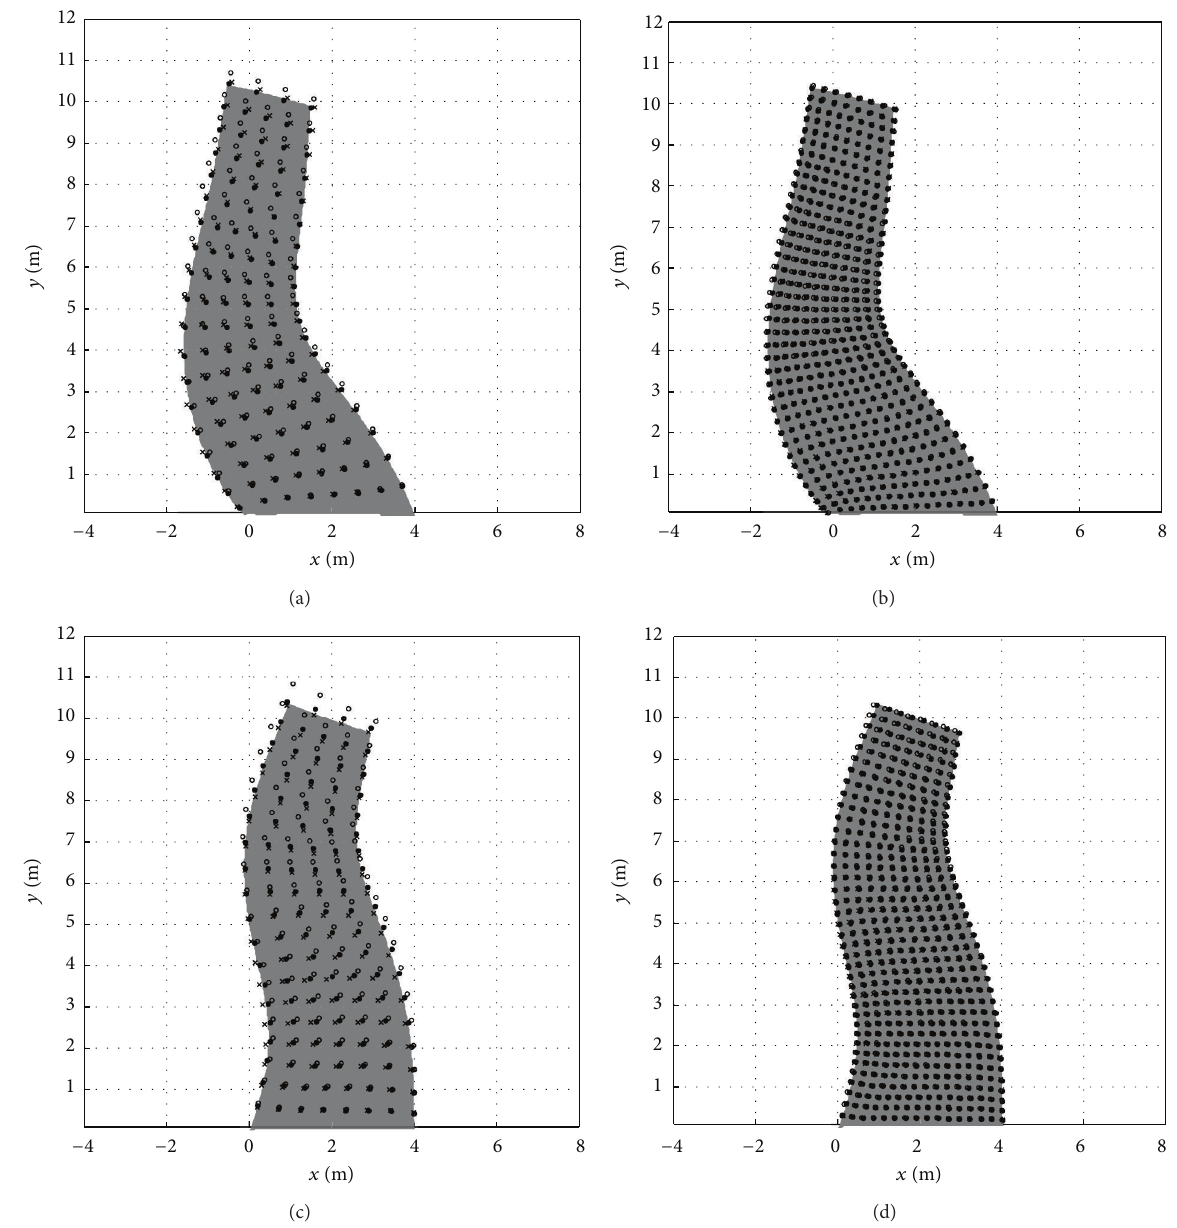
Figure 18: Real ((a) and (b)) and imaginary ((c) and (d)) parts of the deformation of the solid structure (amplified) when the excitation frequency is 125Hz. Results are shown for 20 ((a) and (c)) and 40 ((b) and (d)) boundary nodes in the solid, along the fluid-solid interface, when using the FEM ( × ), CM ( ∘ ), and MLPG ( ∙